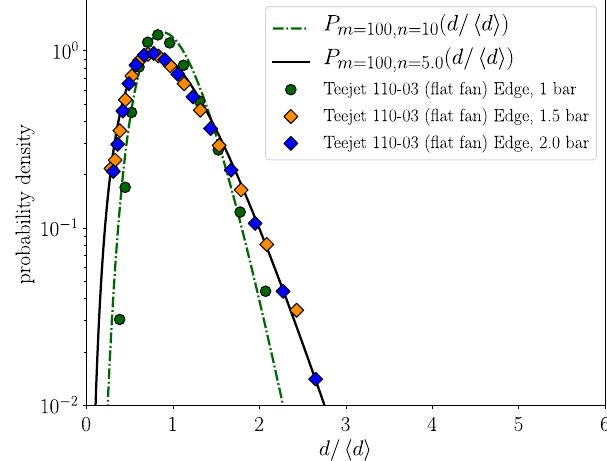
FIG. 11. Droplet size distributions of droplets from the edge of the Teejet 110-03 nozzle (flat fan) with pressures 1.0, 1.5, and 2.0 bar. The ligaments are of uniform size, resulting in m ¼ 100 . For 1.0 bar, the ligaments are still quite smooth with n ¼ 10 , making the distribution more narrow. For pressures ≥ 1 . 5 bar, the ligaments are maximally corrugated, resulting in n ¼ 5